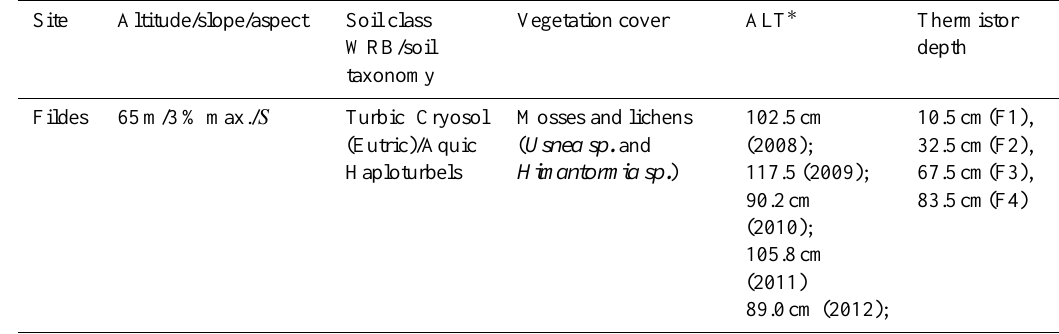
Table 1. General characteristics of the monitored site. Site